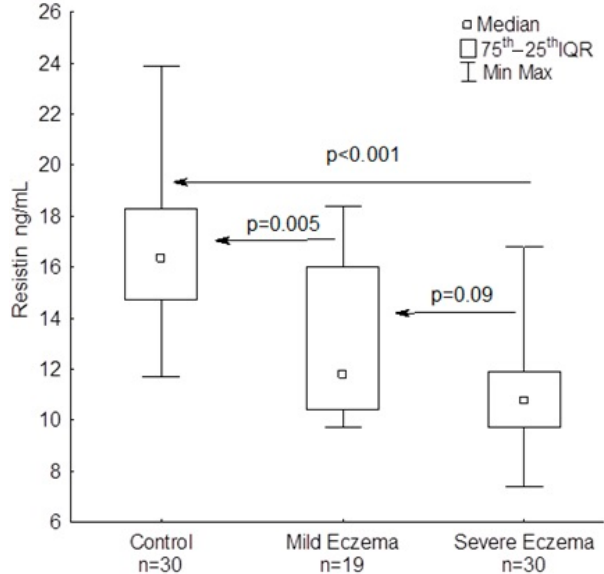
Figure 2. Blood resistin in patients with mild and severe atopic eczema and healthy controls.